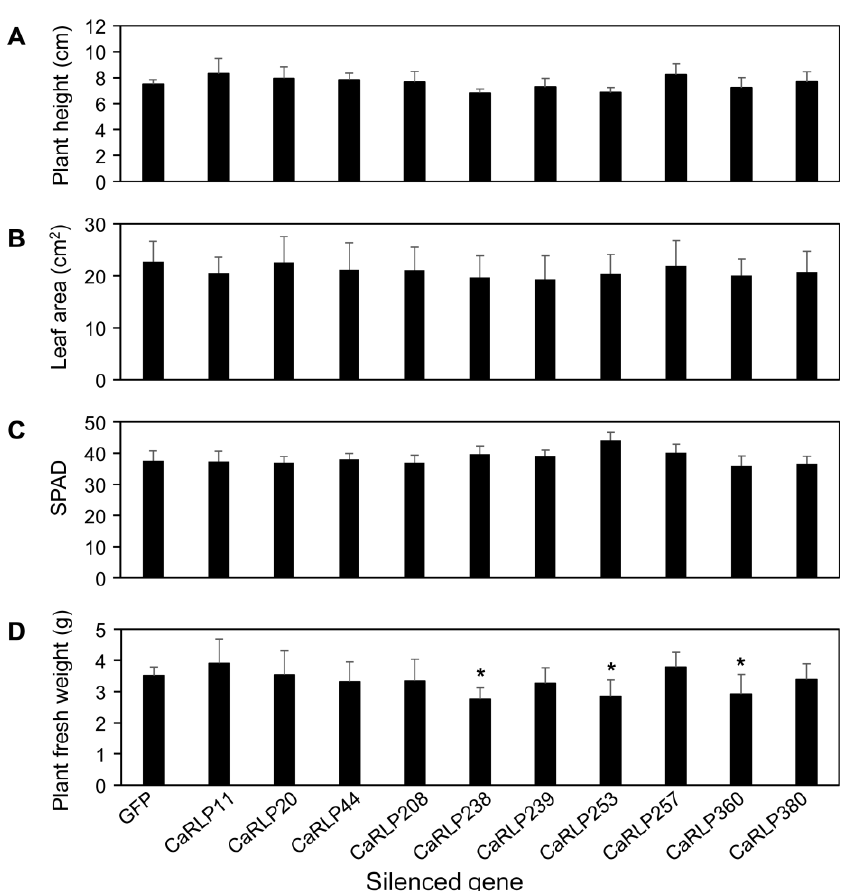
Figure 4. Phenotype analysis of 10 CaRLP ( Capsicum annuum receptor-like proteins)-silenced pepper plants. Comparison of plant height ( A ), leaf area ( B ), chlorophyll contents ( C ), and fresh weight ( D ) in control plants (GFP; green fluorescent protein) and CaRLP-silenced plants. CaRLP-silenced plants and control plants were used for phenotypic analysis at six weeks after silencing. The plant height was measured from the ground to the growth point of the shoot. The plant fresh weight included shoot and root weight. The leaf area and chlorophyll contents were measured on the third true leaf and third and fourth leaves, respectively. Data are shown as mean ± SD. Statistically significant differences compared with the TRV2-GFP control determined using Student’s t-test are indicated by asterisks (* p < 0.05).